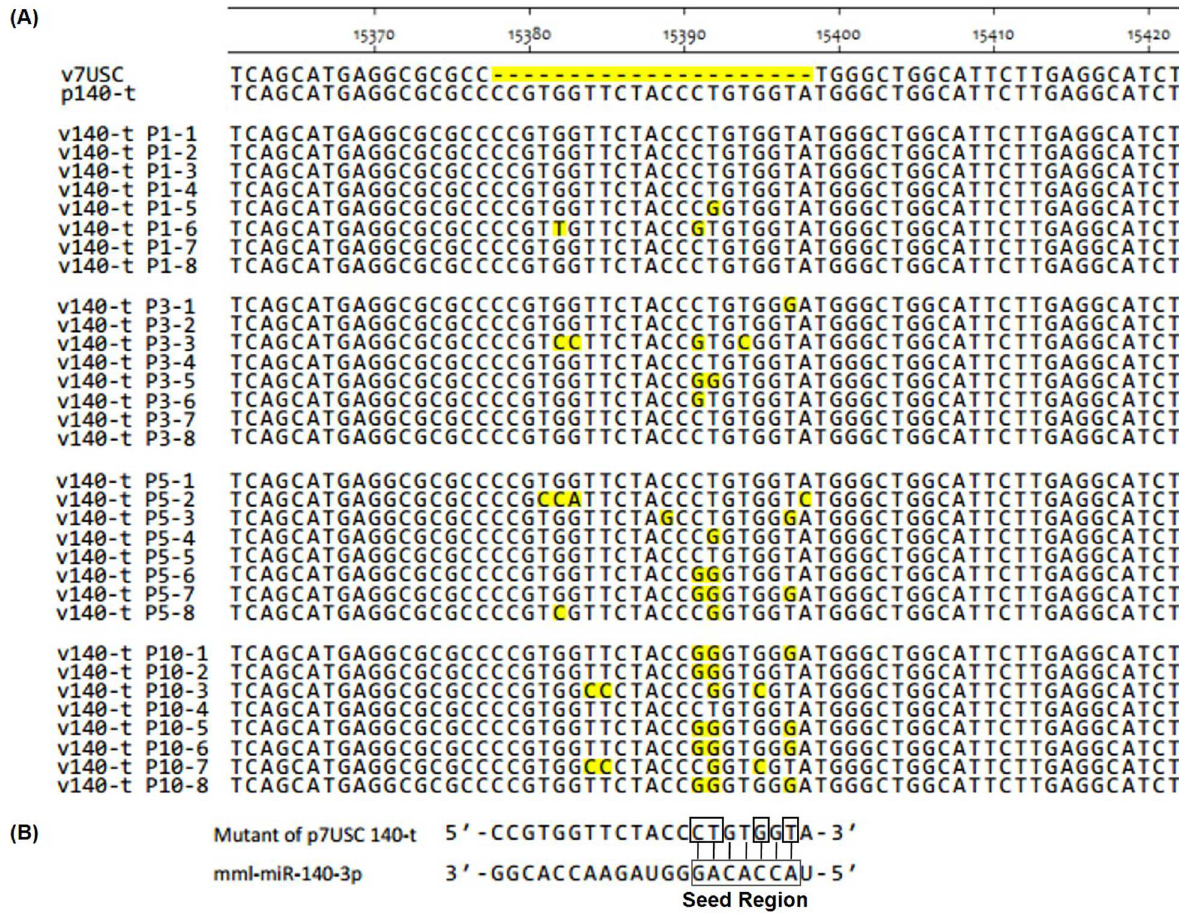
Fig 9. Genetic stability of v140-t (P1, P3, P5 and P10) according to nucleotide sequencing. A: To assess their genetic stability, the supernatants of v140-t (P1, P3, P5 and P10) passages were collected, and the cDNA fragment (nucleotides 14841–15497) containing the insertion sites were amplified by RT-PCR and cloned into the pMD-18T vector for transformation into Escherichia coli . Primer SF14841 was used to analyze the nucleotide sequences, and alignments were performed among the different clones of v140-t in P1, P3, P5, and P10. Spontaneous mutations were shaded in yellow. B: Schematic diagram of spontaneous mutations in the v140-t mutant and the seed region of mml-miR-140-3p.